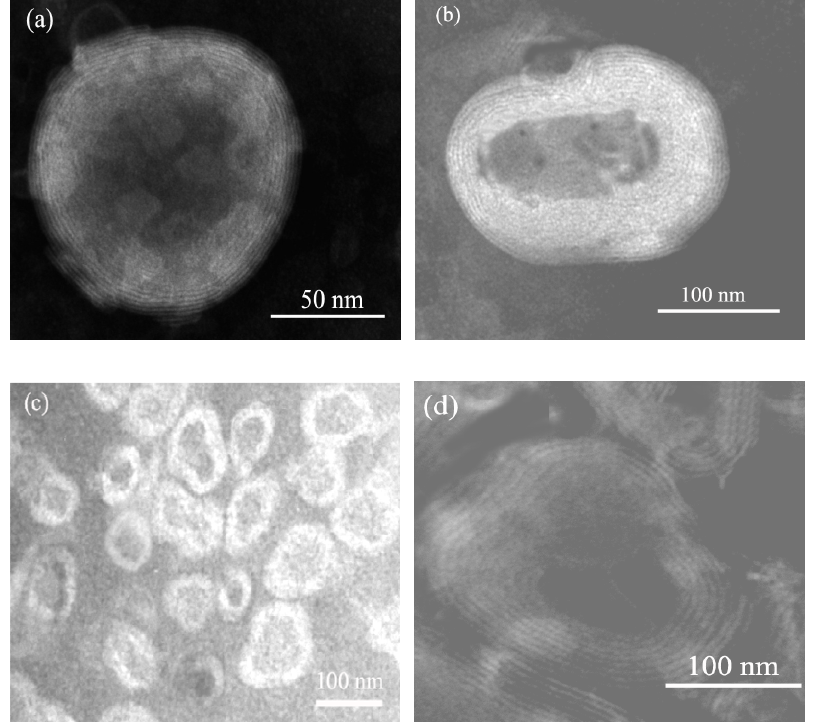
Figure 1. Negative stain electron micrographs of QUE-loaded PEVs prepared with: (a)